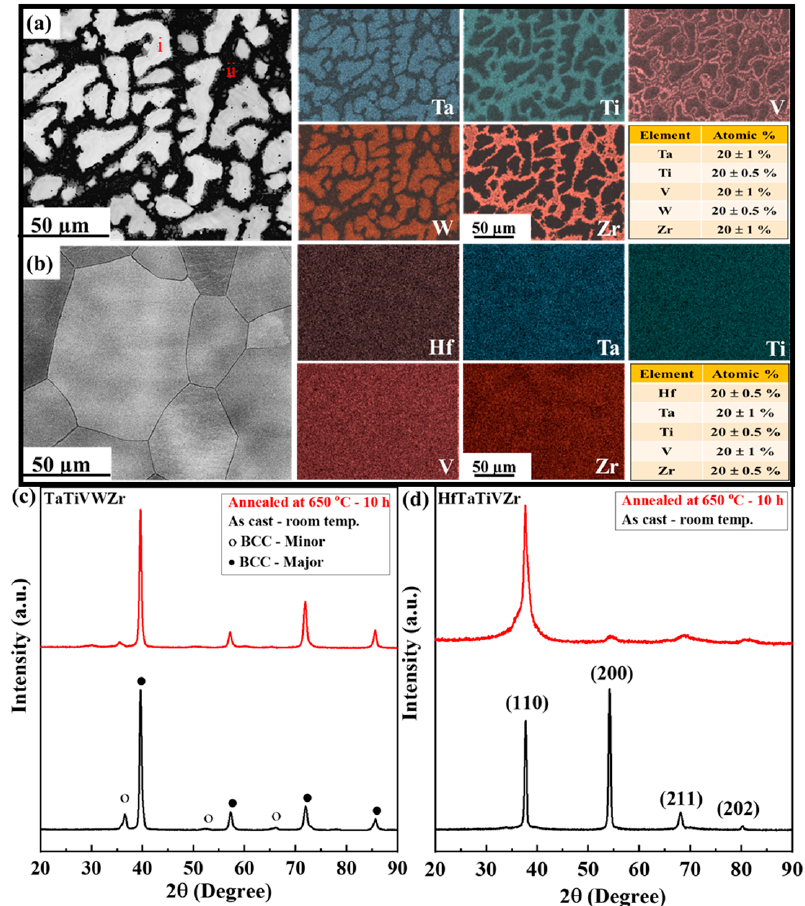
Figure 2. Backscattered SEM micrographs and respective EDS area map for ( a ) TaTiVWZr and ( b ) HfTaTiVZr refractory high-entropy alloys; XRD patterns for as-cast ( c ) TaTiVWZr and ( d ) HfTa-TiVZr refractory high-entropy alloys [34]. Copyright 2021 Elsevier.